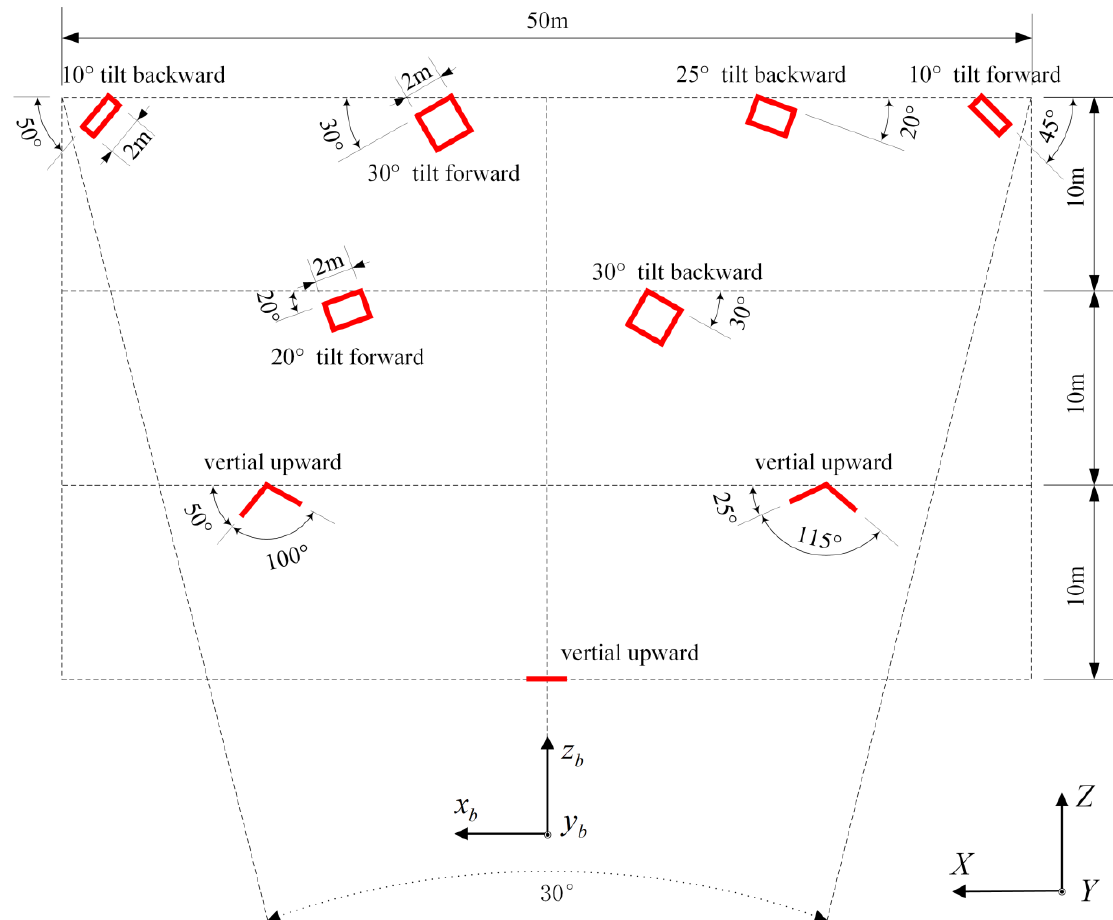
Figure 3. Layout scheme of flat target plates in the Jiading outdoor calibration field. This is a schematic diagram of the effect from the top view from the air. The red rectangle and line represent the flat target board, each is 2 meters wide and 4 meters high, x b , y b and z b indicate the directions of the three coordinate axes of the TDI body coordinate system, X , Y , Z indicate those of the ground coordinate system. The XZ plane is basically parallel to the ground, and the Y axis is vertically upward. During geometric calibration, try to ensure that the orientation of the coordinate axes of the TDI body frame and the ground coordinate system is consistent. In order to effectively separate the influence of the TDI systematic error parameters, the azimuth and pitch angles of each flat target plate in the XZ plane are specially designed, and the corresponding angles are given in the